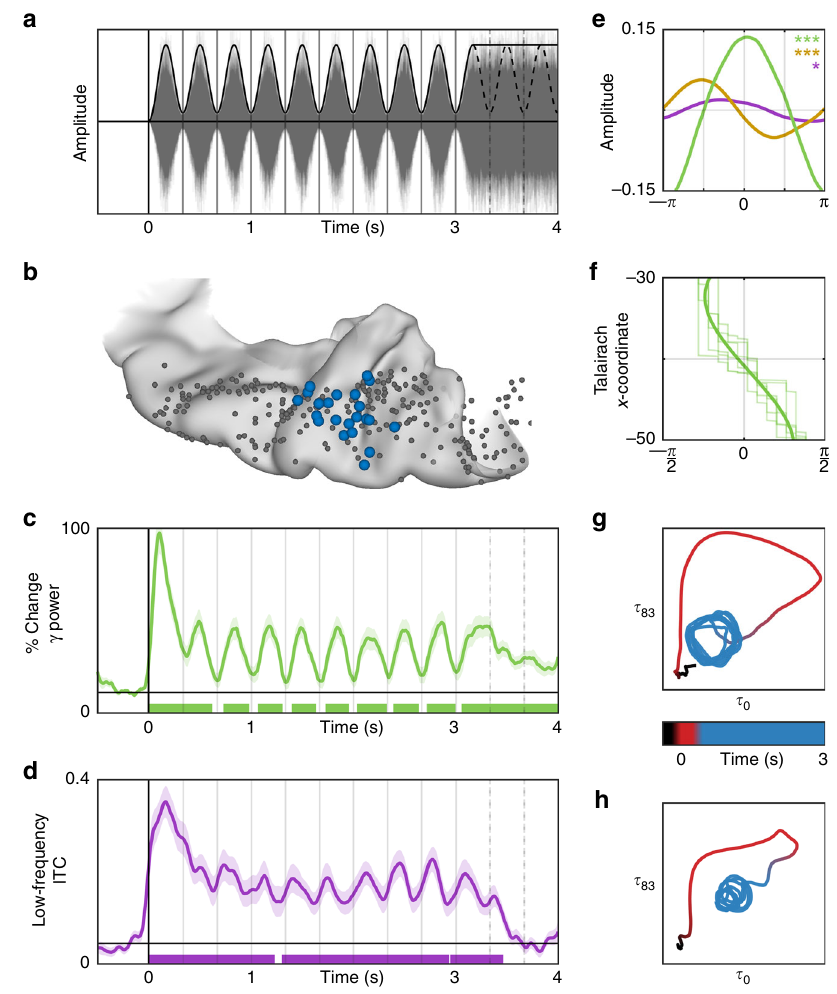
Fig. 3 Response of Heschl ’ s gyrus to rhythmic white noise. Cortical response to rhythmic white noise. a 3 Hz amplitude-modulated white noise stimulus. b The most active electrode (blue) was selected from all electrodes (gray) in each patient with a supratemporal depth probe ( n = 26). These were used for the following analyses. c Average percent change in high-gamma (65 – 115 Hz) power relative to pre-stimulus baseline. Shaded area represents ±1 standard error of the mean. Signi fi cance was determined with the Wilcoxon signed-rank test at an alpha level of p < 0.01 using familywise error correction. d Average absolute change in low-frequency (2 – 15 Hz) inter-trial coherence (ITC) from a pre-stimulus baseline. e Average amplitude of low (purple), beta (yellow), and high-gamma (green) frequencies relative to the stimulus phase during the sustained response (pulses 2 – 9) demonstrating frequency- multiplexed encoding of acoustic envelope. Signi fi cance (* p < 0.05, ** p < 0.01, *** p < 0.001) was determined with bootstrapping ( n = 1000) of Kullback – Leibler divergence from a uniform distribution across phase for low ( p = 0.038), beta ( p < 0.001), and high-gamma ( p < 0.001) frequencies. f Spatial distribution of peak high-gamma power timing relative to stimulus phase demonstrates a traveling wave (velocity 0.1 m/s) that begins medially at the insular boundary (top) and progresses to the lateral edge (bottom). The mean wave (dark lines) is superimposed over the wave at each pulse (light lines). g , h Phase space trajectory at a quarter period delay (83 ms) in high-gamma power (top) and low frequency ITC (bottom). Time indicated by color: pre-stimulus baseline (black), red ( fi rst acoustic pulse), blue (pulses 2 –